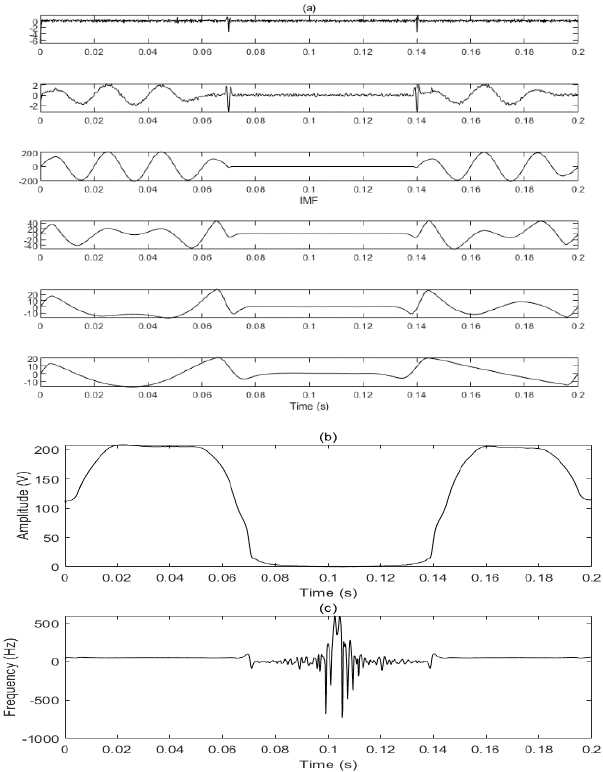
Figure 17. Voltage interruption IMF components ( a ), amplitude ( b ), and frequency ( c ).